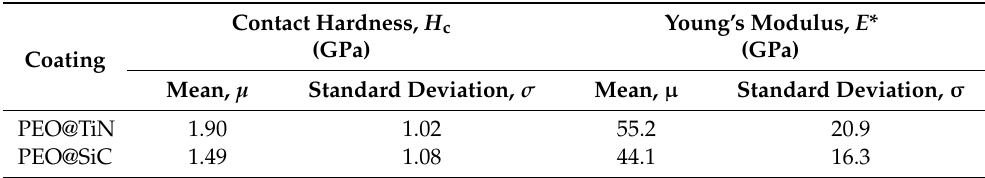
Figure 10. Cumulative distribution function of ( a ) contact hardness H c , and ( b ) Young’s modulus E * for the two coatings. Table 3. Mean value and standard deviation of H c and E * for the two coatings.